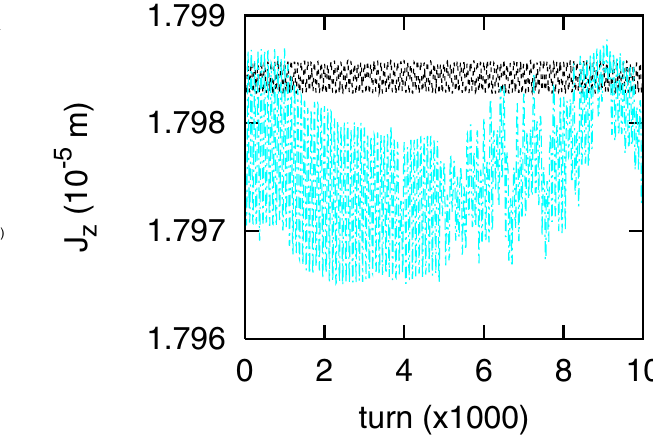
for the particle marked light blue z